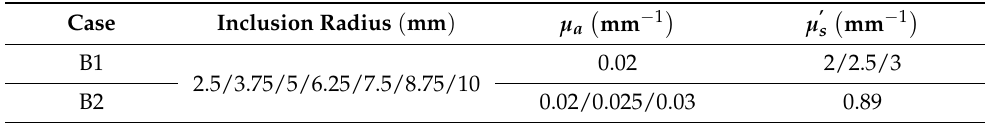
Table 2. Simulation cases for image